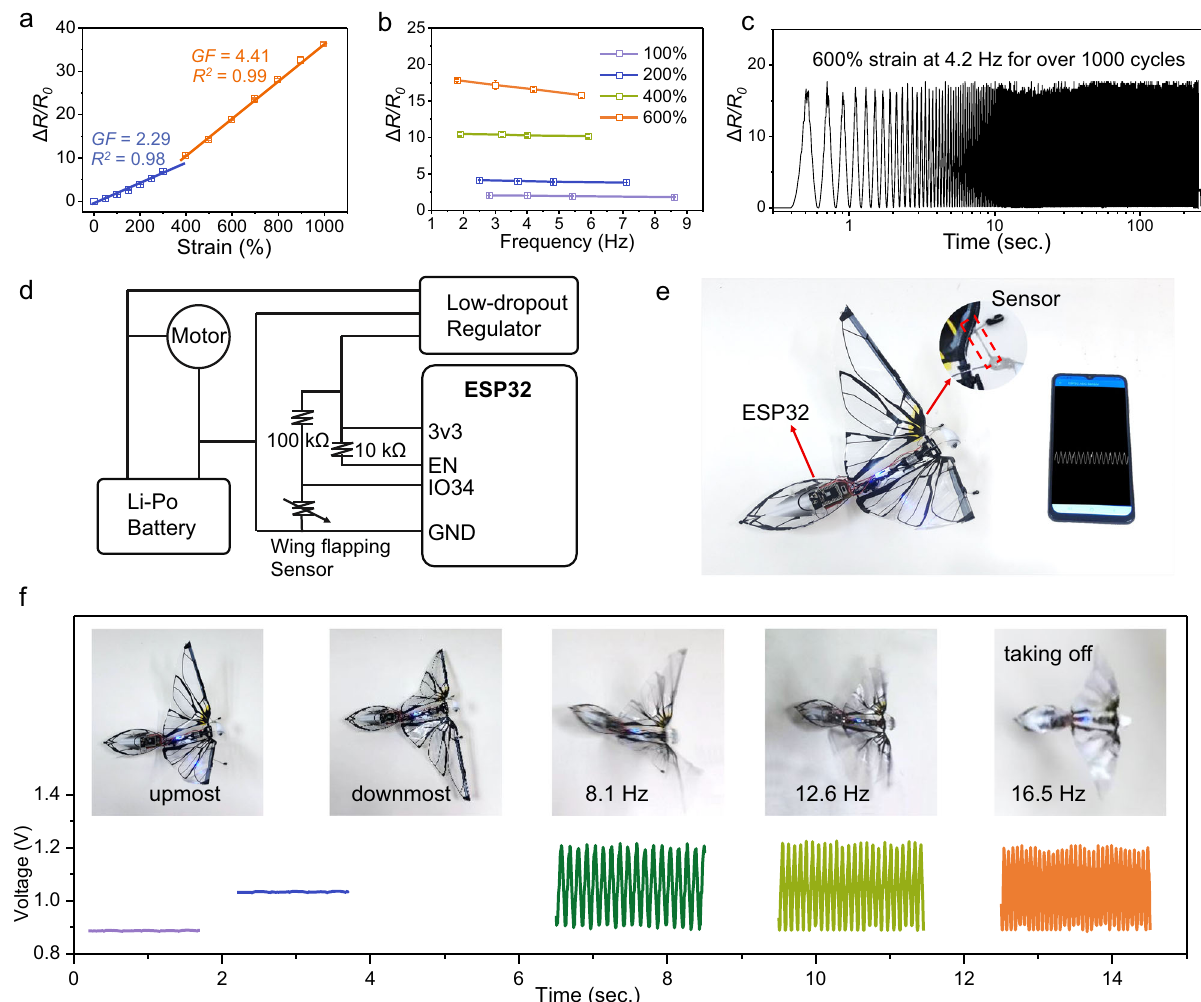
Fig. 4 Fast resilient ionic hydrogel fi ber sensors monitoring large-strain, high-speed motions. a Resistance change of the hydrogel fi ber versus tensile strain, and the gauge factor ( GF ). R 2 represents the coef fi cient of determination of the fi tting. b Resistance change versus stretching frequency at different strains. c Resistance change during cyclic stretching at 600% strain and 4.2 Hz for over 1000 cycles. d Circuit scheme of the fi ber sensor for wirelessly monitoring wing fl apping of a robotic bird. e Photograph of the robotic bird installed with the hydrogel fi ber sensor, bluetooth chip and power source. f Wirelessly received sensing signals corresponding to different motion states of the robotic bird. Error bars represent